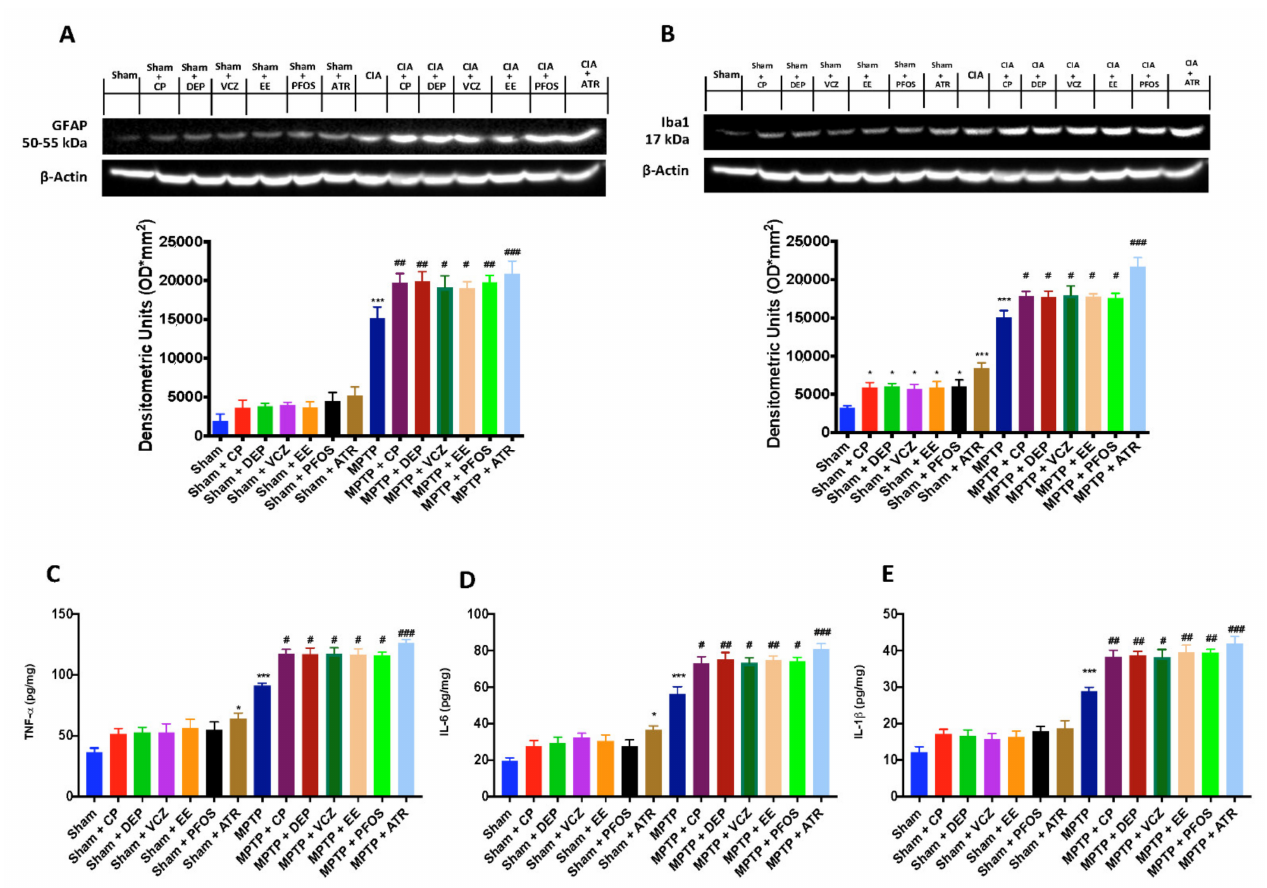
Figure 4. Western blots and densitometric analysis of GFAP ( A ) and Iba1 ( B ). Levels of TNF- α ( C ) IL-6 ( D ) and IL-1 β ( E ). A demonstrative blot of lysates with a densitometric analysis for all animals is shown. Data are expressed as mean ± SEM of N = 6 mice/group. * p < 0.05 vs. sham; *** p < 0.001 vs. sham; # p < 0.05 vs. MPTP; ## p < 0.01 vs. MPTP; ### p < 0.001 vs.